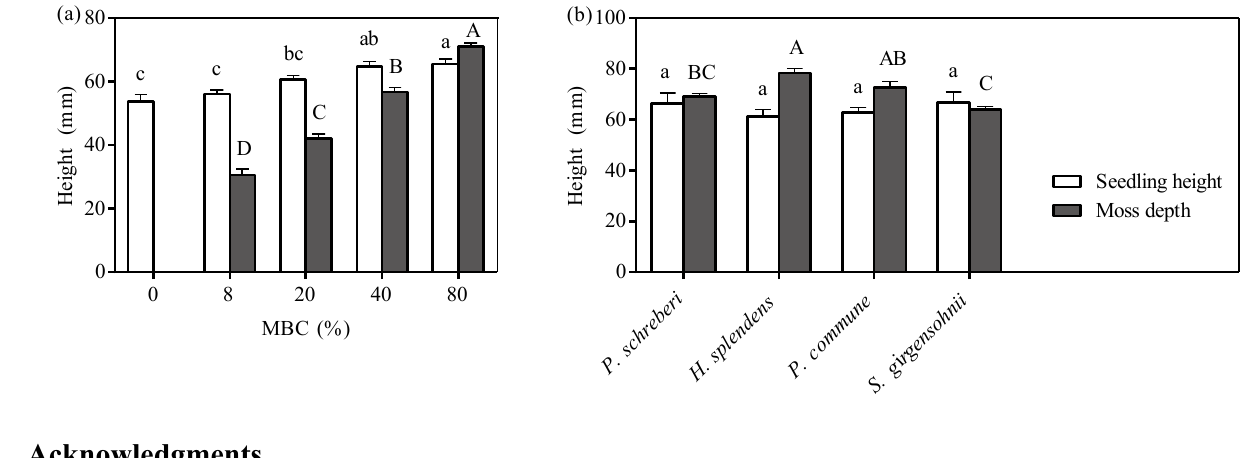
Figure S1. ( a ) Pinus sylvestris seedling height (white bars) and moss depth (black bars) at the end of the experiment for each moss biomass class (MBC) across all moss species and ( b ) for each moss species at the 80% MBC; for both panels, different lower case letters indicate significant differences in seedling height at p < 0.05 and different capital letters indicate significant differences in moss depth at p < 0.05 according to Tukey’s HSD test; ANOVA results for seedling height across MBC are given in Table 1; and for moss species at 80% MBC F = 0.68 ( p = 0.60); for moss depth, across MBC F = 285.86 3.39 3.155 = 11.77 ( p < 0.001); bars show ( p < 0.001); and for moss species at 80% MBC F 3.39 means + SE; the vertical axis scale refers to both seedling height and moss